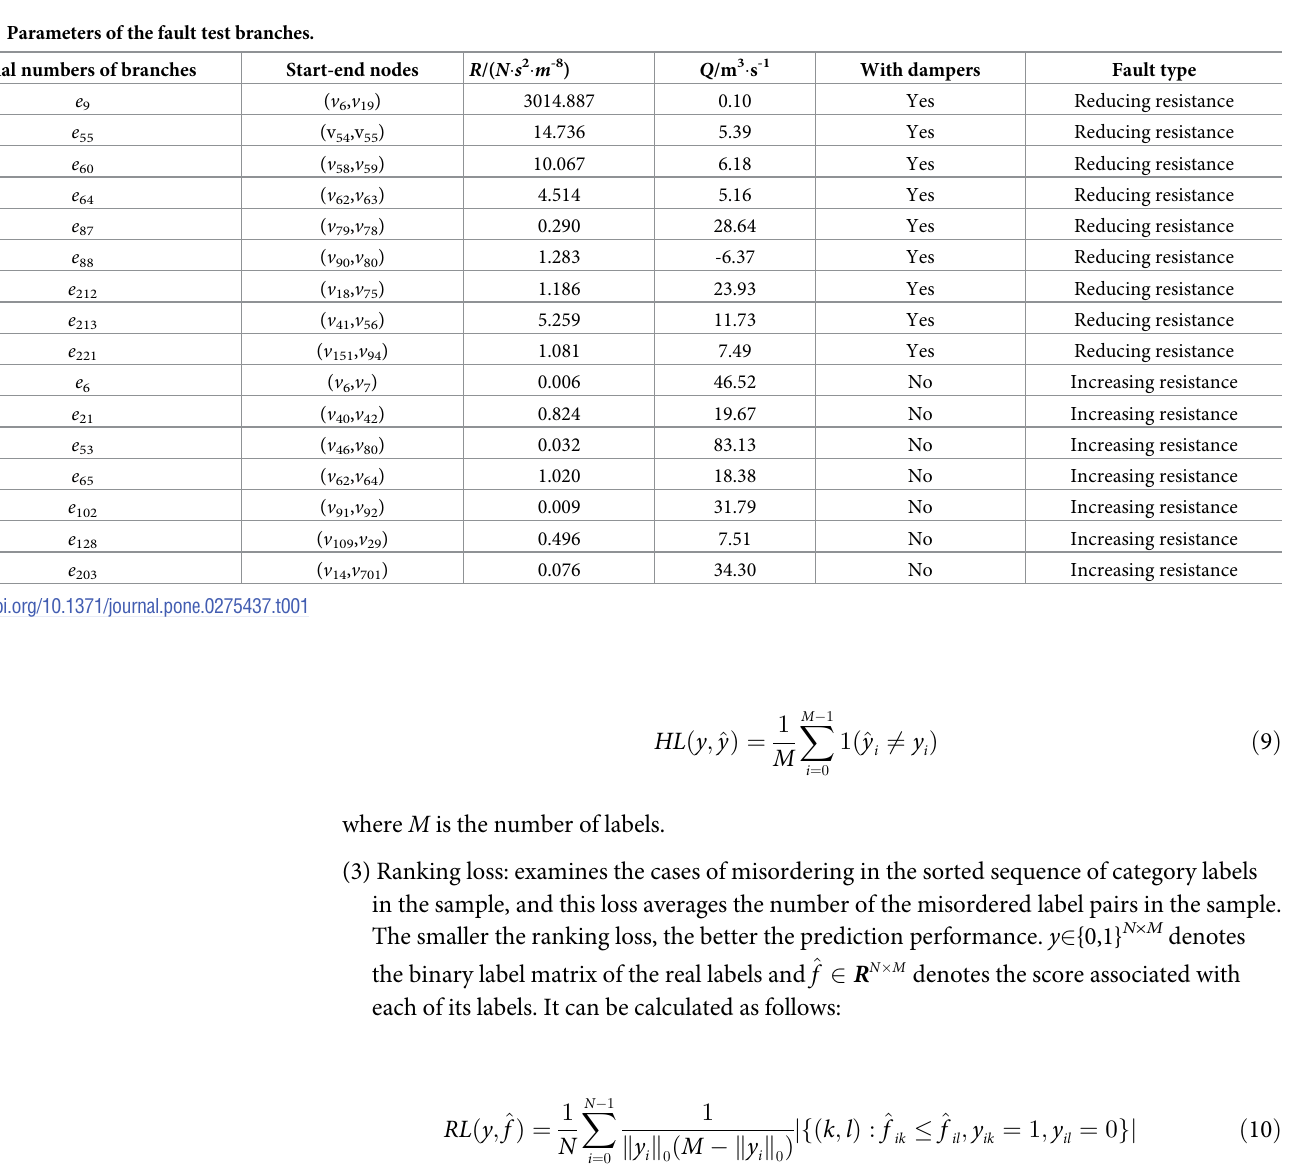
calculates the number of non- 0